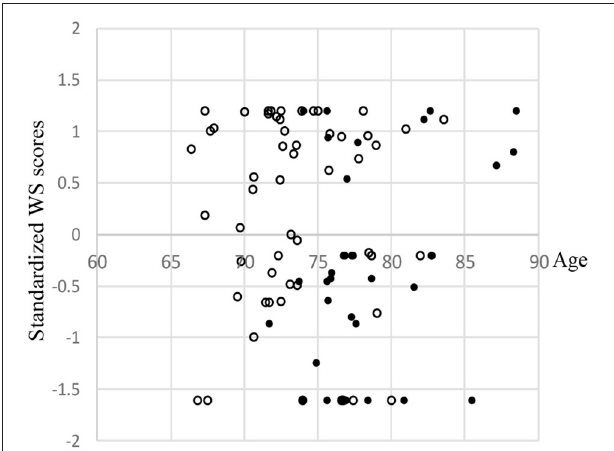
participant’s age.